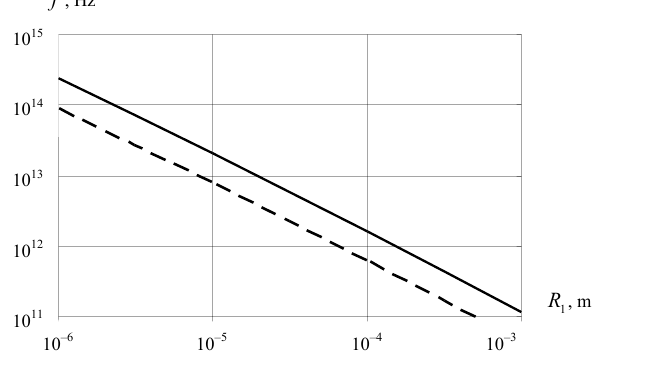
H , – ∙ – E for the 101 101